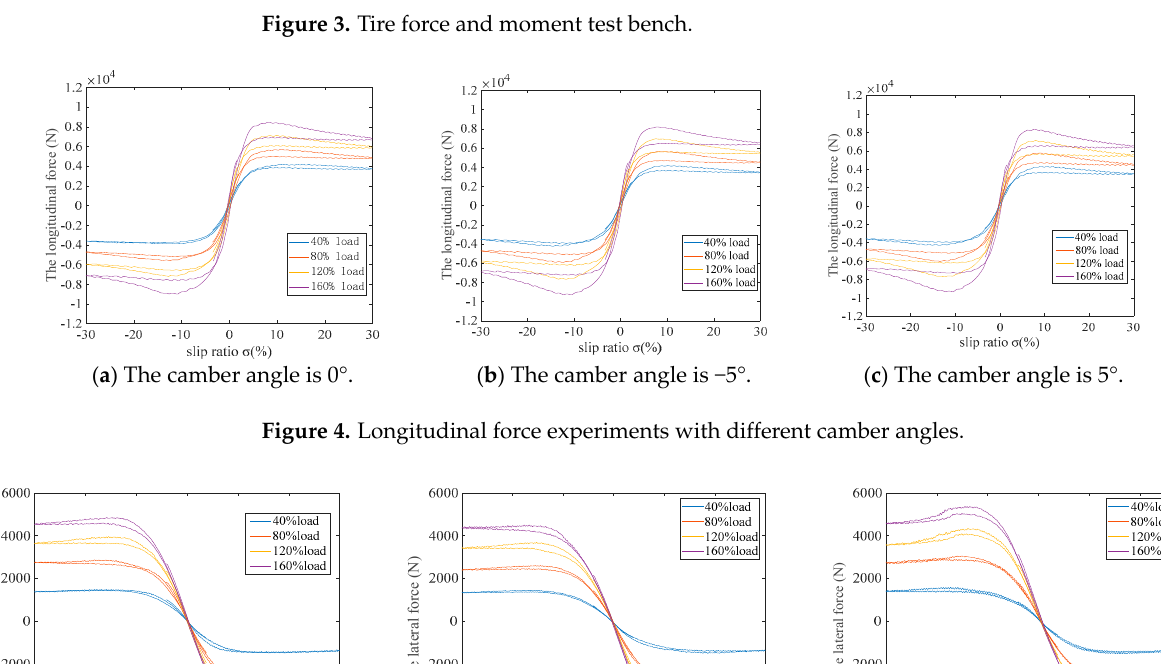
Table 4. Main parameters of the 4WID vehicle. Variable Parameters